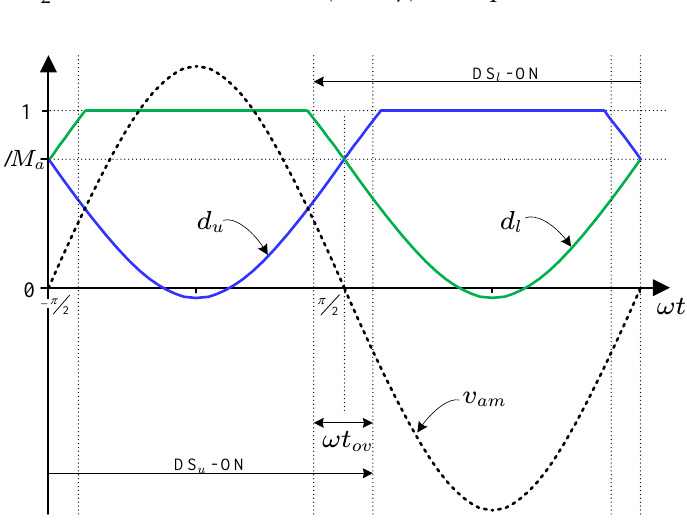
Figure 2. Operation of the director switches, duty cycles, and overlap period of the AAC.